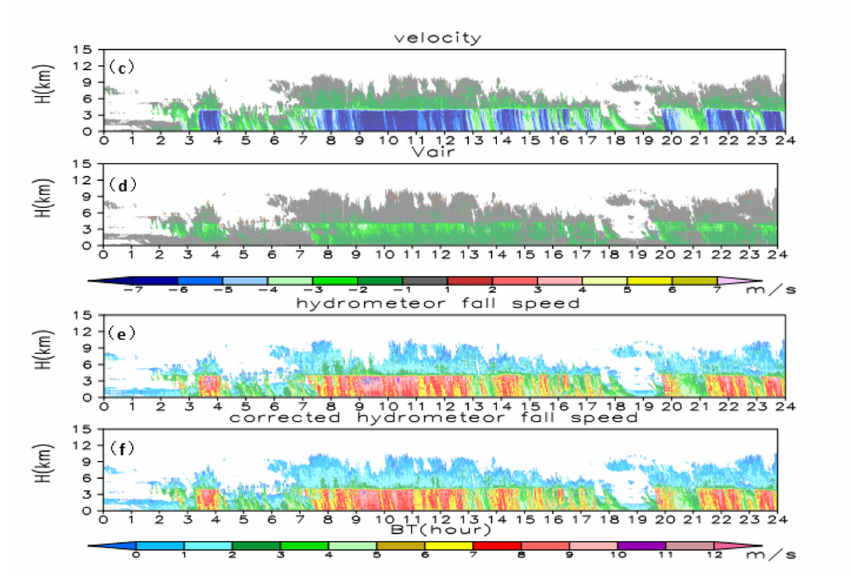
Figure 6. Time–height cross sections for recalculated reflectivity ( a ) before and ( b ) after attenuation correction, ( c ) velocity, ( d ) vertical air speed, ( e ) hydrometeor fall speed, and ( f ) corrected speed to ground. The black rectangle in ( a ) represents the aircraft observation period.